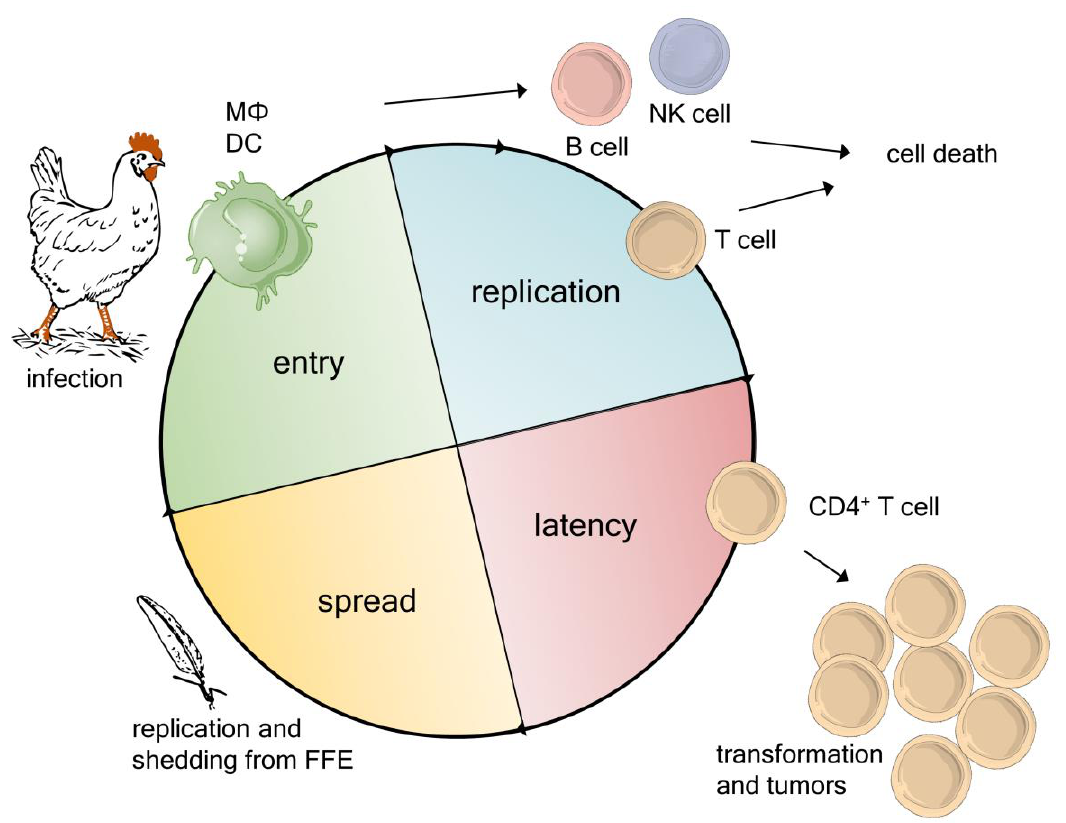
Figure 1. Marek’s disease virus (MDV) infection starts with the inhalation of infectious dust. Mononuclear phagocytes transfer the virus to lymphoid organs, such as the spleen, thymus, and bursa, where the virus lytically replicates in lymphocytes. MDV is able to establish latency in infected T cells. Latently and / or lytically infected T cells transport the virus to the skin and feather follicle epithelia (FFE), where cell free MDV is generated. In addition, MDV can transform latently infected T cells, resulting in deadly lymphomas.